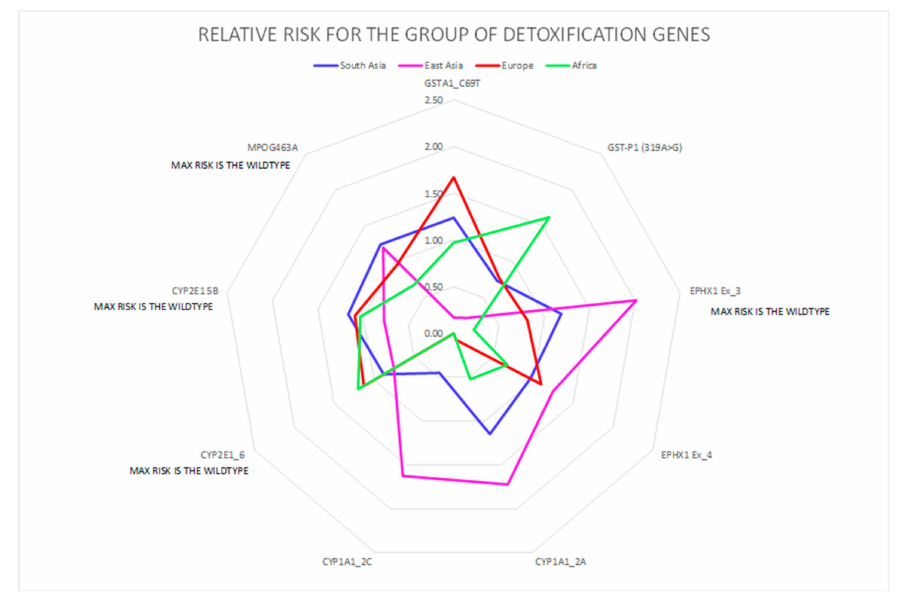
Figure 3. Detoxification polymorphic genes are highlighted with di ff erent colors in the four ethnic groups. The genes are represented by geometrical figures, where the tip of figure points toward the most susceptible genes belonging to each gene